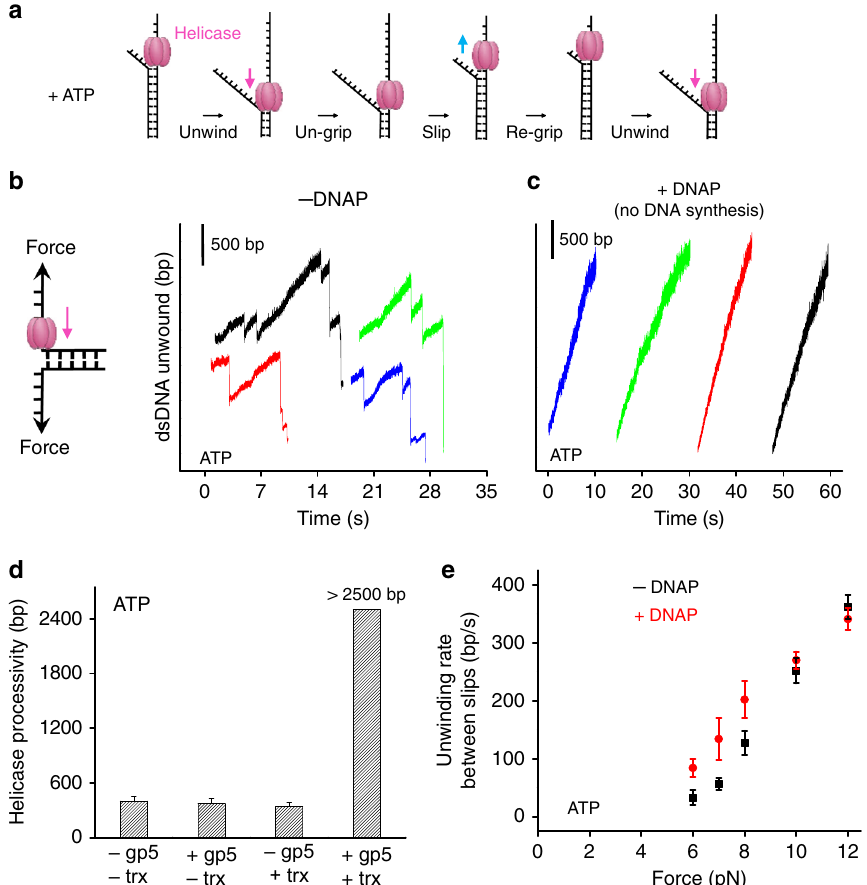
Fig. 1 Non-replicating DNAP prevents helicase slippage and increases unwinding rates. a Cartoon illustrating T7 helicase unwinding and slippage behavior. The helicase unwinds, loses grip, slips, re-grips, and resumes unwinding. Arrows indicate the directions of helicase movements. b , c Representative traces showing the number of unwound base pairs by T7 helicase vs. time in the absence (28 traces in total) or presence (25 traces in total) of non-replicating DNAP, respectively. Experiments were conducted with 2 mM ATP under 8 pN force. For clarity, traces have been arbitrarily shifted along both axes. d Measured processivity of T7 helicase (mean distance between slippage events) in the absence and presence of gp5 and/or trx with 2 mM ATP under 8 pN external force. e T7 helicase unwinding rates between slips as a function of force in the absence or presence of the DNAP with 2 mM ATP. Unwinding rates were determined between slippage events (if any). Error bars represent standard